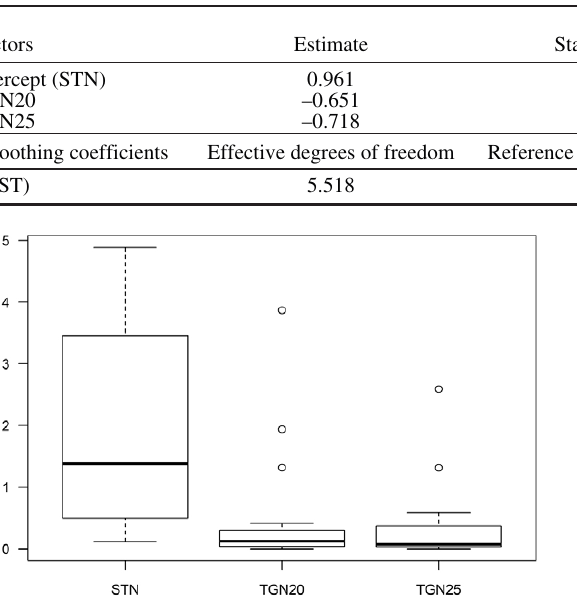
Table 5. – Summary table of the GAM analysis on the biomass index of the discarded species .